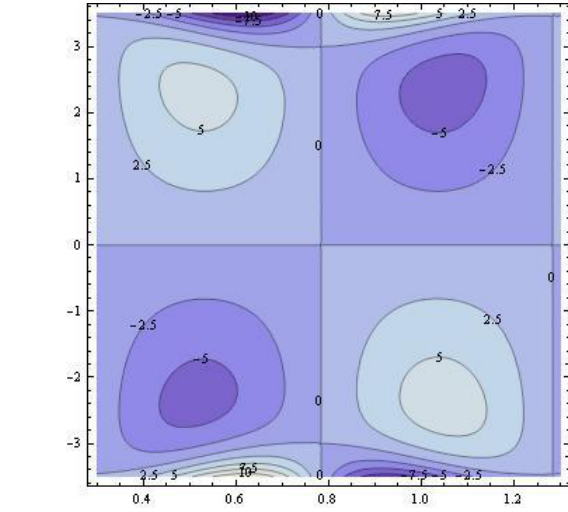
= 1. Figure 23(b). Stream lines for 𝜆 1